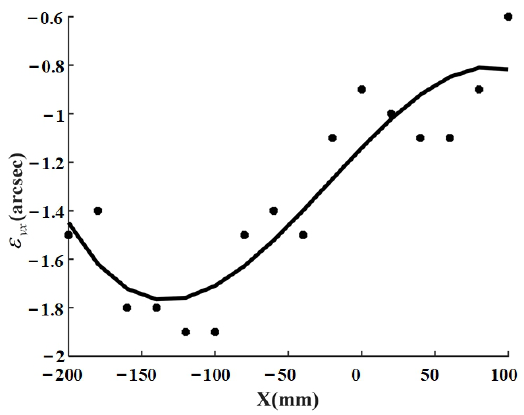
 . Figure 11. 3rd order fitting curve of X-axis geometric error ε yx  .